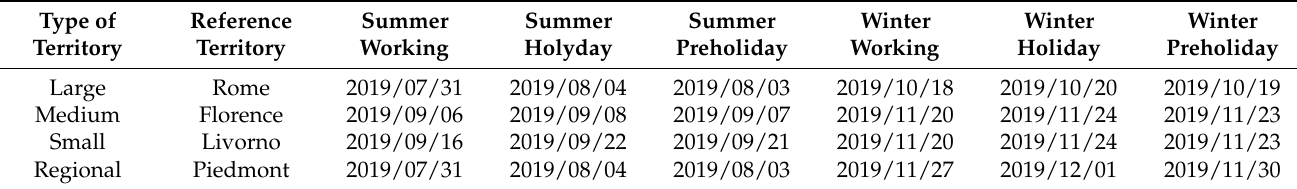
Figure 6. Hourly distribution of the fleet mileage obtained by GTFS data representative for different territory classes (cities and Regions). Table 1. Reference territories and dates used to compute the fleet mileage distributions shown in Figure 6. Dates are expressed as